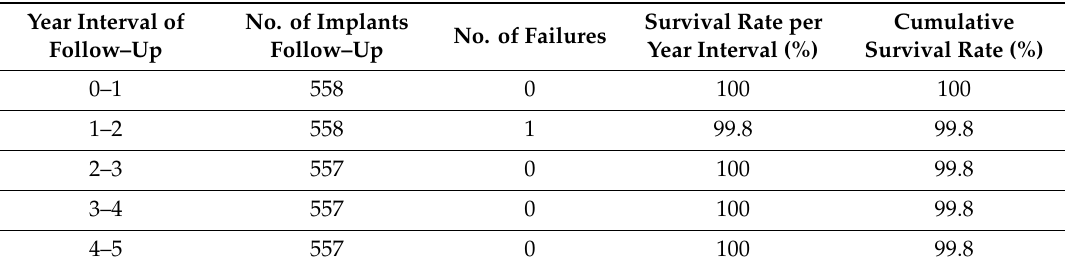
Table 10. Life table on implant level.